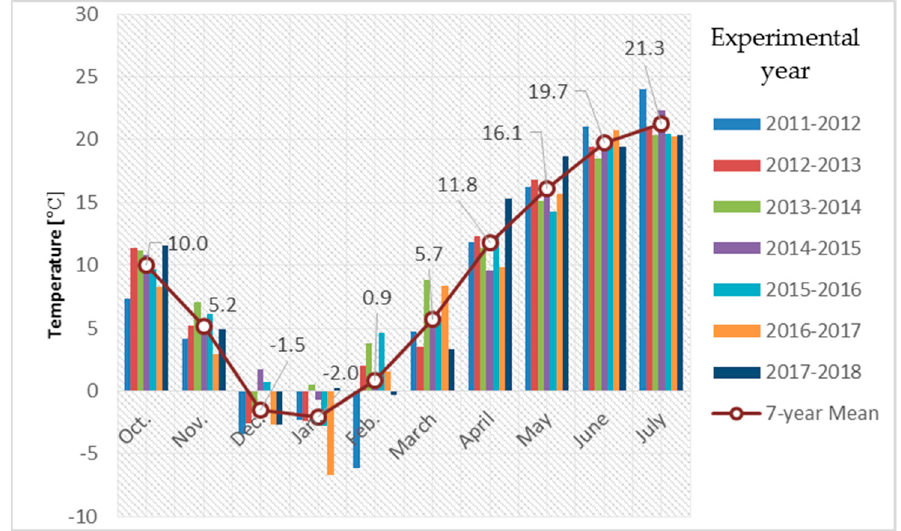
Figure 1. Average monthly air temperatures for the seven vegetation seasons and the 7-year mean.